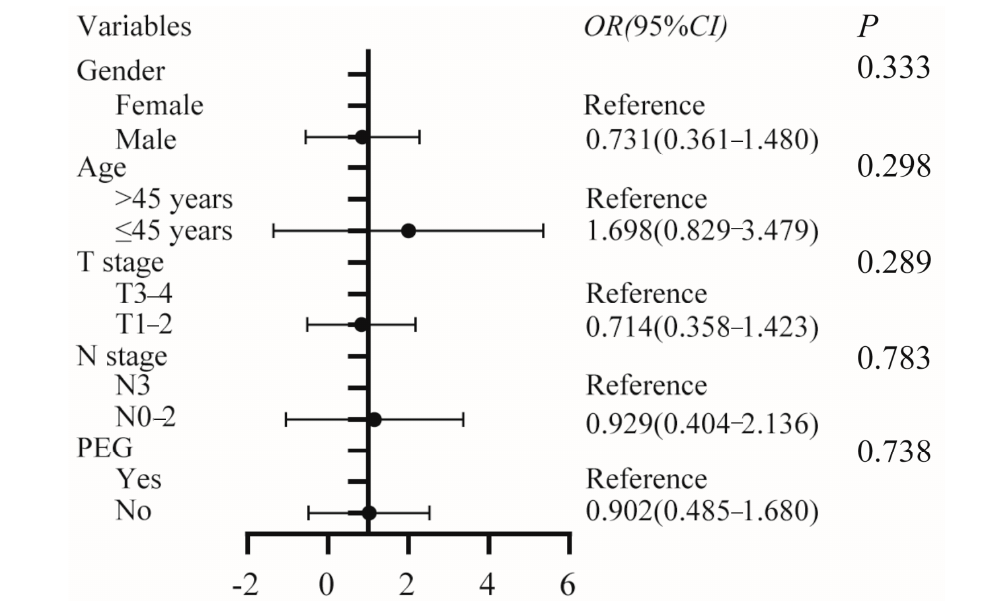
Table 3. Comparison of quality of life between non-PEG and PEG